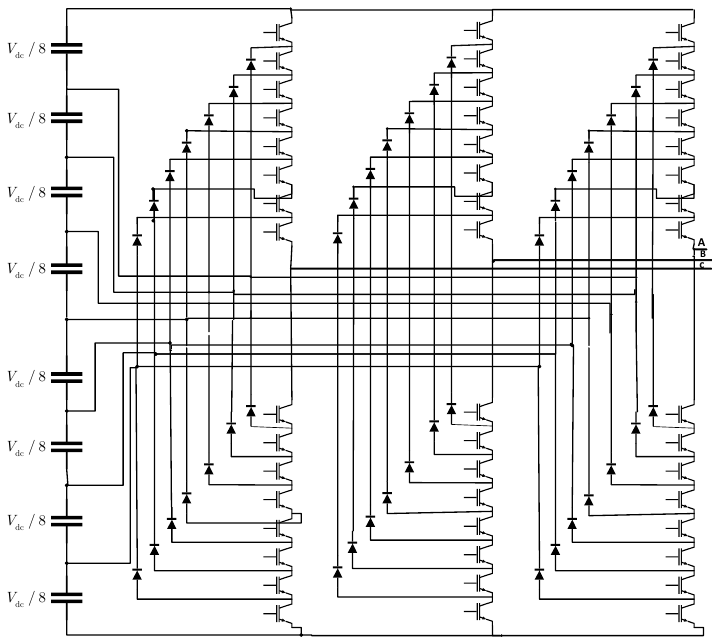
Figure 2. Structure of the converter used in the multilevel